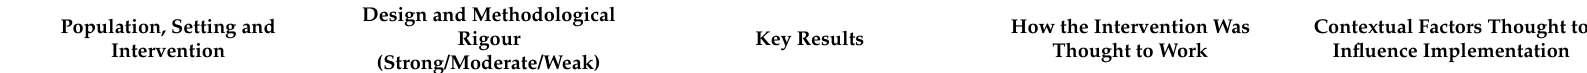
Table 2. Summary of papers included in the realist literature